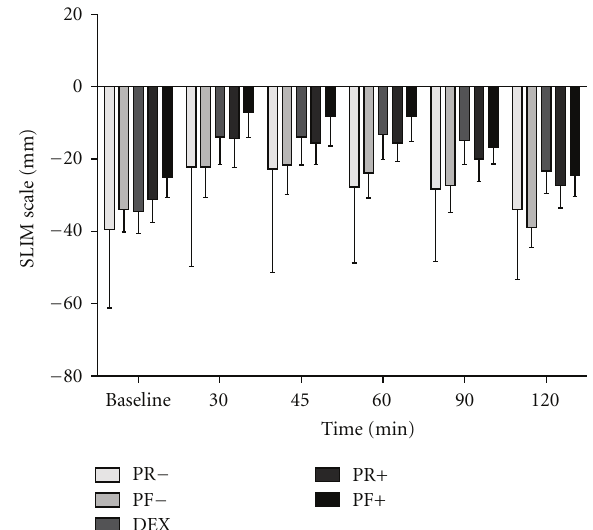
Figure 2: The satiety responses, using the Satiety Labeled Intensity Magnitude scale (SLIM), to consuming 38 g of resistant starches with water, (PF − and PR − ), with 50g of dextrose (PF+ and PR+), and 50 g of dextrose only (DEX), means ±